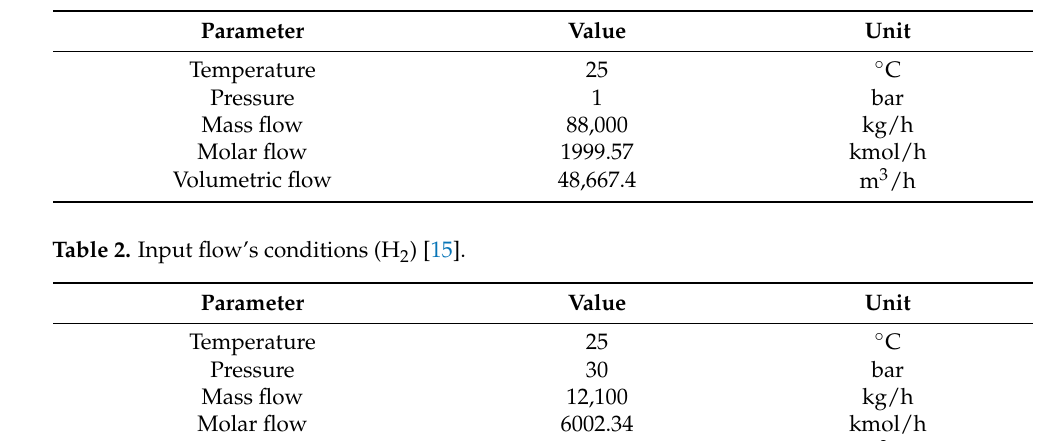
Table 1. Input flow’s conditions (CO 2 ) [15].